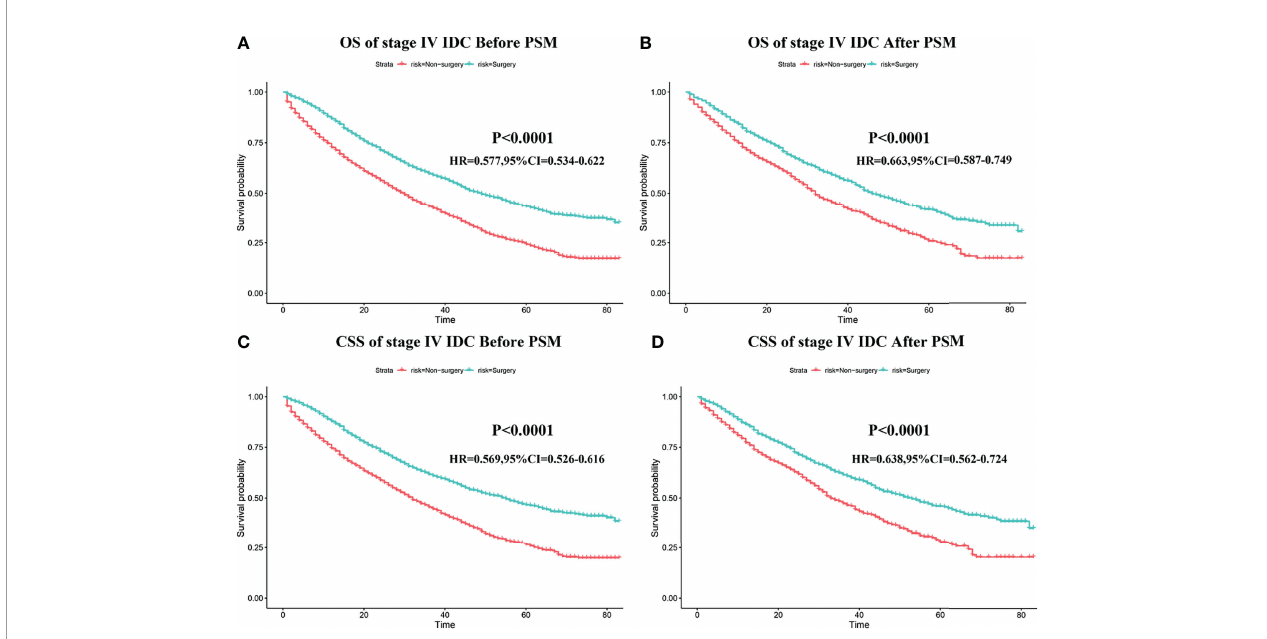
FIGURE 2 | The impart of primary tumor resection on the survival outcomes of patients with stage IV BIDC. Kaplan – Meier (K-M) survival curves of overall survival (OS) before PSM (A) and after PSM (B) , and cancer-speci fi c survival (CSS) before PSM (C) and after PSM (D) in the surgery and non-surgery